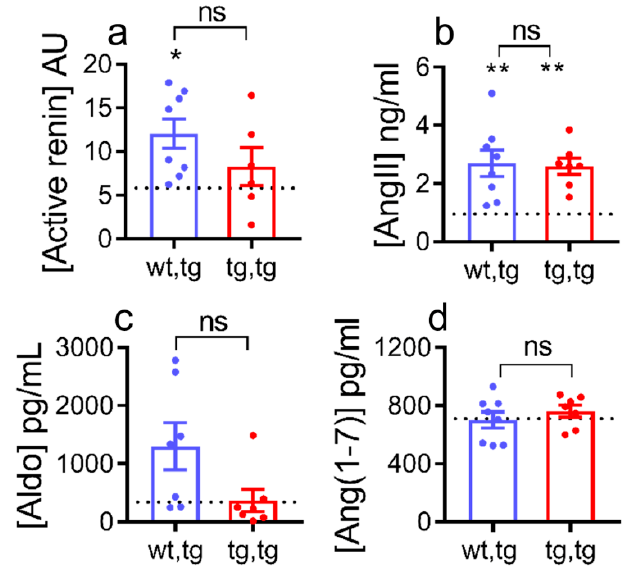
Figure 6. Effect of cardiac corin-Tg(i) overexpression on plasma RAAS biomarkers in female DCM mice. Plasma levels of ( a ) active renin (arbitrary units, AU), ( b ) angiotensin II (AngII), ( c ) aldosterone (Aldo), and ( d ) angiotensin 1–7 (Ang(1–7)) in corin-Tg(i)/DCM ( ● , tg,tg) and corin-WT/DCM ( ● , wt,tg) mouse groups, at 90 days of age, n = 6–8 per group; dotted line represents control levels in corin-WT/WT (wt,wt) mice. Data are represented as mean ± SE, differences were analyzed (for ( a ), ( b ), and (d)) by one-way-ANOVA using Newman–Keuls multiple comparison test, and by Kruskal–Wallis test using Dunn’s multiple comparison test (for (c)). ** p < 0.01, * p < 0.05 (tg,tg or wt,tg vs. wt,wt); ns = non-significant.